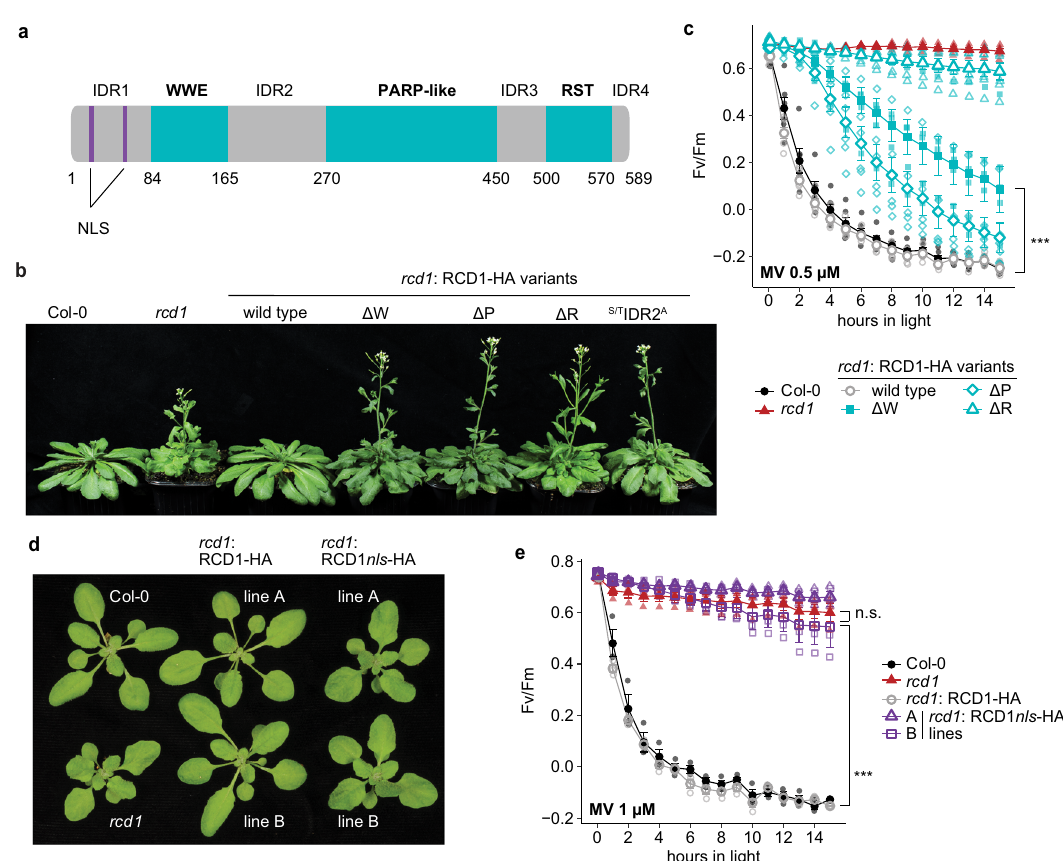
Fig. 1 Nuclear localization and all three domains of RCD1 are essential for its function. a Schematic representation of RCD1 domain structure containing a bipartite NLS, WWE, PARP-like and RST domains. Intrinsically disordered regions are marked as IDR1-4. b Early fl owering phenotype of rcd1 is not reverted by expression of RCD1 Δ WWE-HA ( Δ W), RCD1 Δ PARP-like-HA ( Δ P), RCD1 Δ RST-HA ( Δ R), and RCD1 S/T IDR2 A -HA in rcd1 background. Picture shows 5- week-old plants of representative lines under standard growth conditions. c Wild-type MV sensitivity is not restored in lines expressing RCD1 Δ WWE-HA ( Δ W), RCD1 Δ PARP-like-HA ( Δ P), and RCD1 Δ RST-HA ( Δ R) constructs. PSII inhibition (Fv/Fm) by MV was measured in indicated lines using 0.5 μ M MV. For each experiment, leaf discs from three individual rosettes were used. The experiment was performed three times with similar results. Mean ± SD are shown. * – P value < 0.05 with Tukey corrected post hoc test at the selected time point between rcd1 : RCD1 Δ PARP-like-HA and rcd1 : RCD1-HA lines; *** – P value < 0.001 with Tukey corrected post hoc test at the selected time point between rcd1 : RCD1 Δ WWE-HA and rcd1 : RCD1-HA lines. Source data and full statistics are presented in Supplementary Data 1. d Leaf shape phenotype of rcd1 can be complemented by re-introduction of wild-type RCD1-HA, but not by RCD1 with mutated NLS (RCD1 nls -HA) into the mutant background. The photo shows 3-week-old plant rosettes of two independent lines (A and B) for each construct under standard growth conditions. e RCD1 requires its NLS to complement the rcd1 -speci fi c MV tolerance. PSII inhibition (Fv/Fm) by methyl viologen (MV) was measured in indicated lines using 1 μ M MV. For each experiment, leaf discs from three individual rosettes were used. The experiment was performed three times with similar results. Mean ± SD are shown. *** – P value < 0.001 with Tukey corrected post hoc test; n.s. – nonsigni fi cant difference. Source data and statistics are presented in Supplementary Data